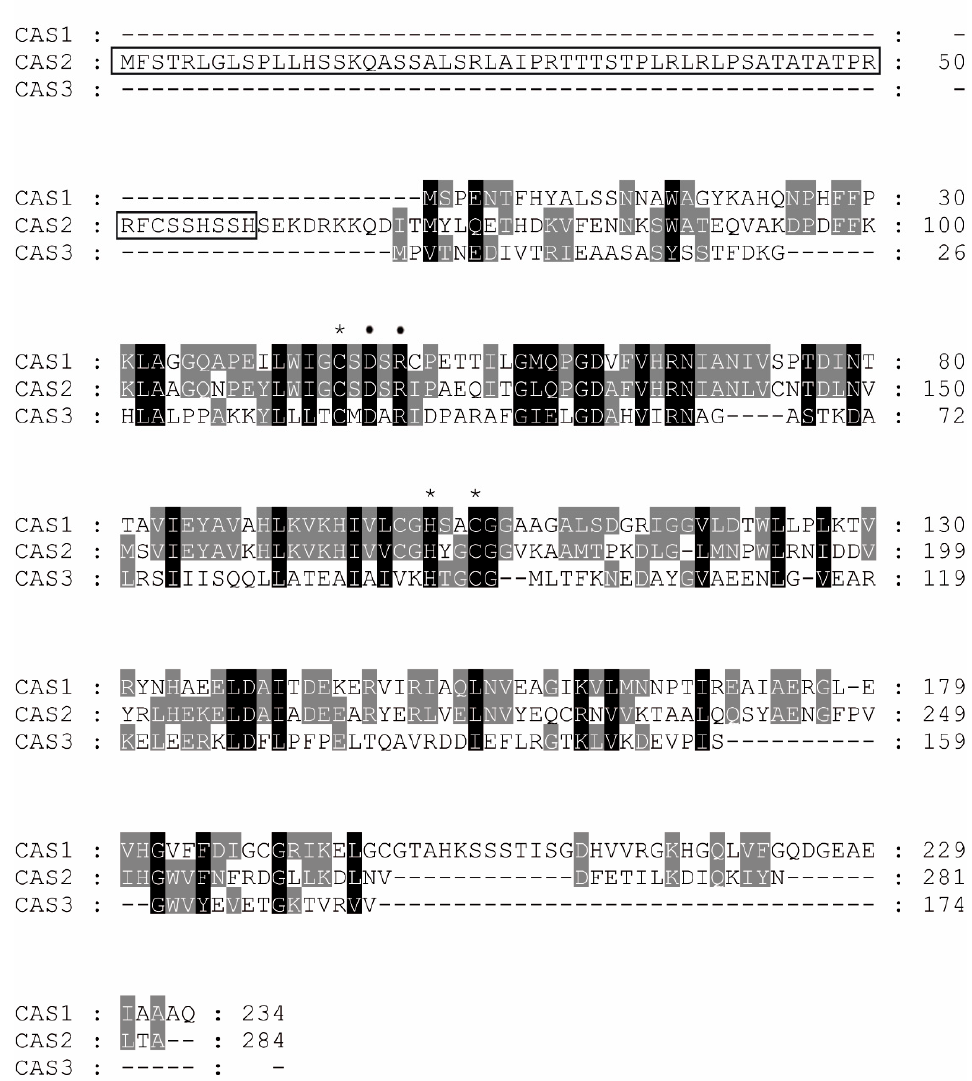
Figure 1. Alignment of three β -class CAs from Sordaria macrospora . Sequences were aligned to using ClustalX [43]. Residues, which are conserved in all three sequences, are indicated in white and highlighted in black, and identical amino acids in the two sequences are highlighted in grey. Conserved amino acids that are predicted to be important for zinc-coordination (Cys41, His93 and Cys96 in CAS3) are marked by an asterisk, and residues of the catalytic dyad (Asp43 and Arg45 in CAS3) are marked by a dot. Amino acid positions are given as numbers at the right side of the alignment. The N-terminal mitochondrial target sequence (aa 1–59) of CAS2 is boxed.